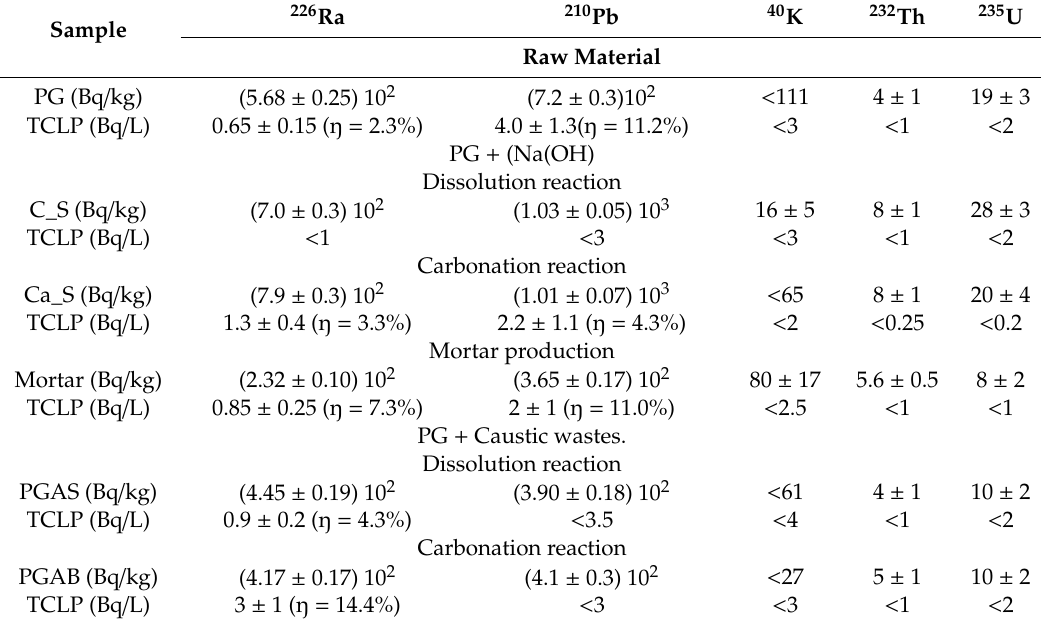
Table 5. Average activity concentrations of the di ff erent radionuclides present in chemical process phases. Average activity concentration with the TCLP (Toxicity Characteristic Leaching Procedure) leaching test of the di ff erent radionuclides and corresponding transfer factors ( ŋ